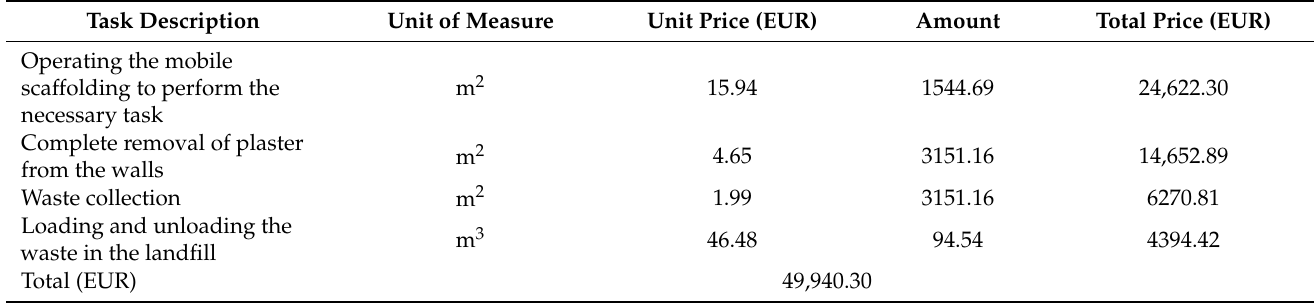
Table 9. Calculation of renovation costs—preparatory works (all strengthening methods).